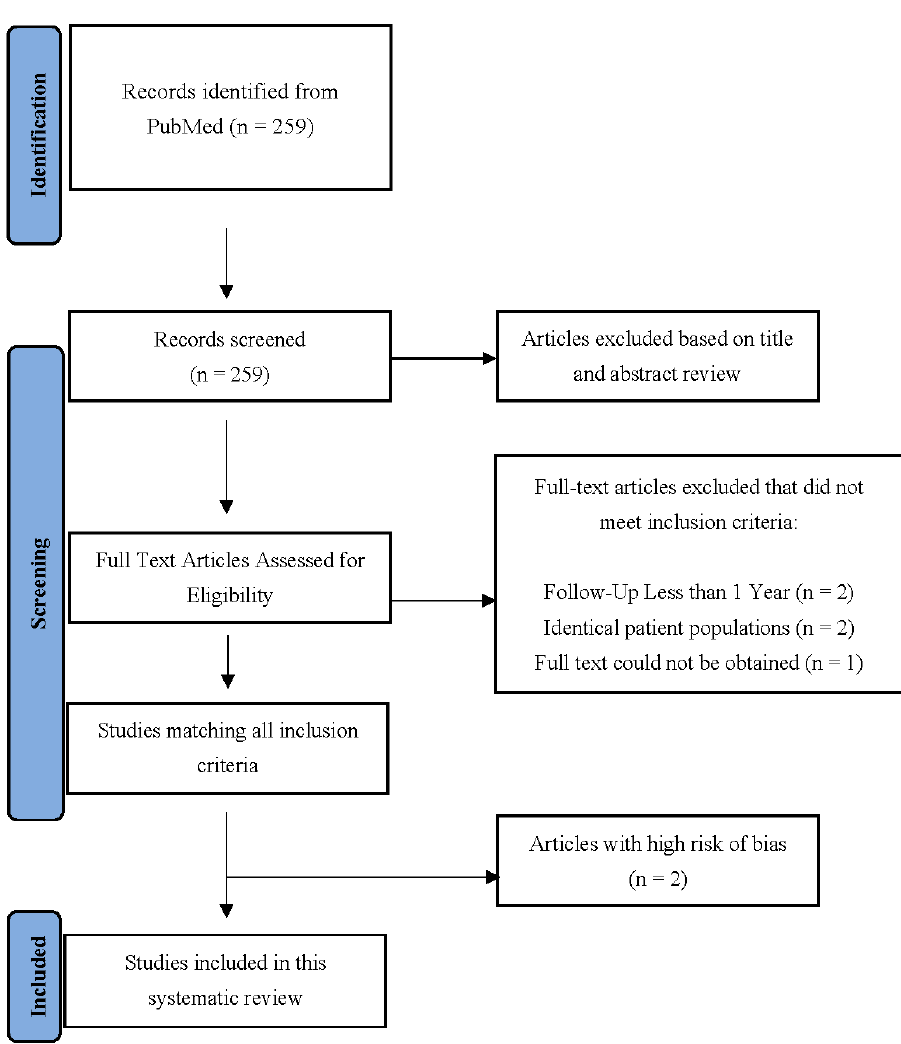
Figure 1. The PRISMA flow diagram describing article selection for